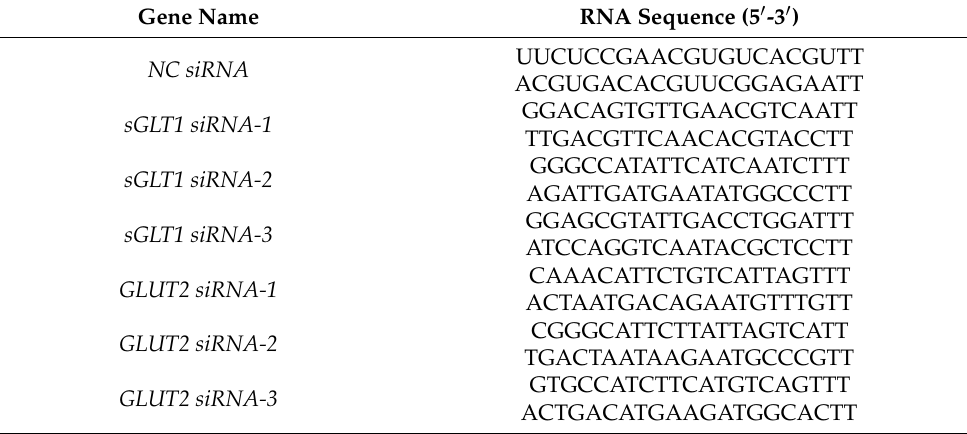
Table 1. Interfering RNA